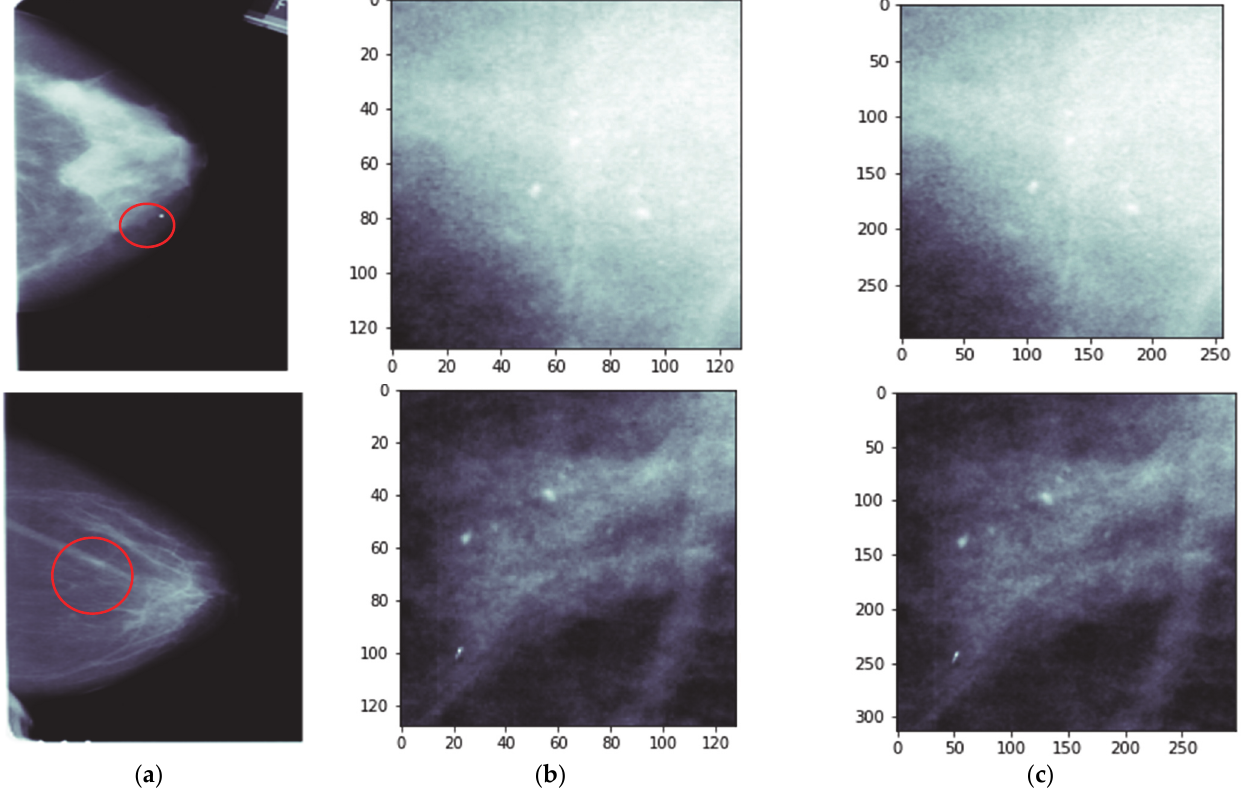
Figure 1. ( a ) Original mammogram images taken from DDSM dataset; ( b ) cropped ROI images of original images; ( c ) resized ROI images of size 299 × 299. original images; ( c ) resized ROI images of size 299 ×